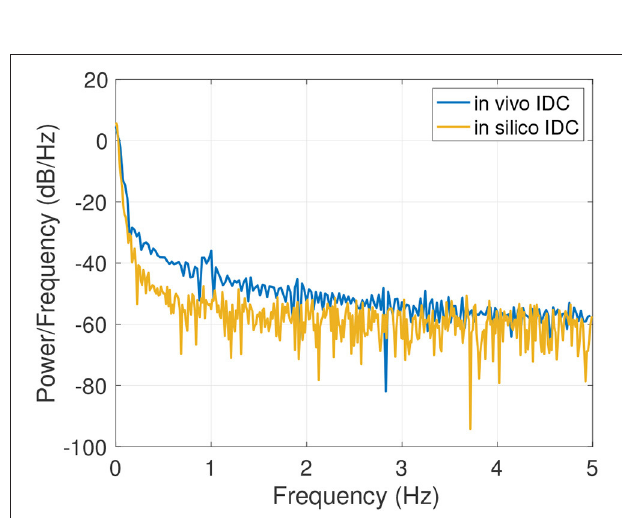
FIGURE 7 | Power spectral density of the in vivo and in silico data in the spectral rang of up to 5 Hz